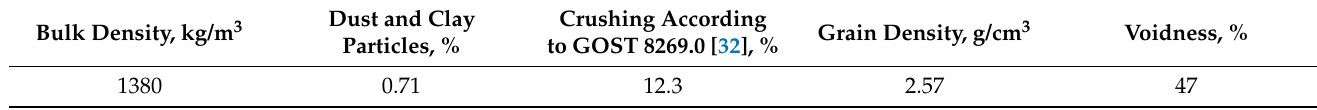
Table 3. Physical and mechanical characteristics of coarse aggregate.